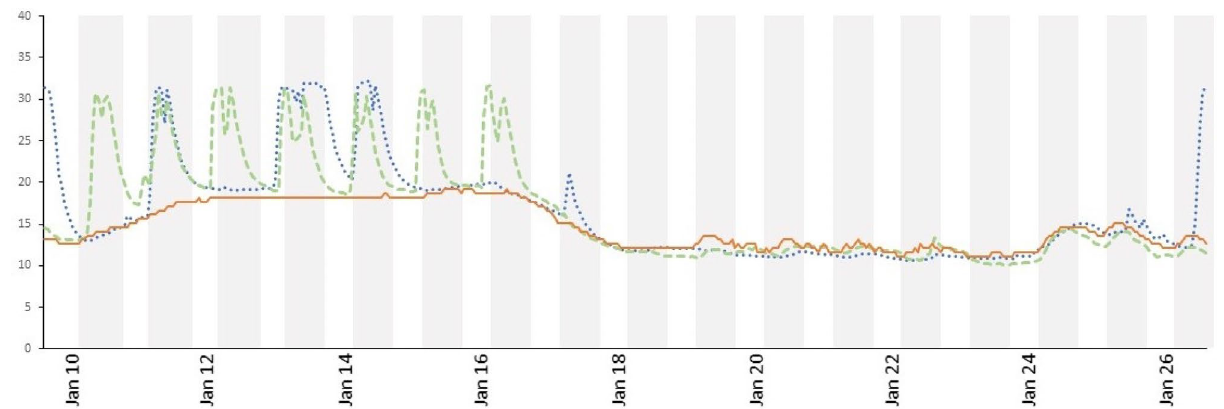
Figure 5. Tsk from female “Ra” (blue, dotted line) and male “Au” (green, dashed line) and Twall (orange, solid line) profiles from Jan 10 to 26 during a “warming” period followed by cold spell. Gray areas show “night”